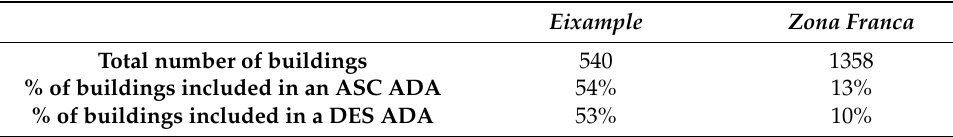
Table 6. Summary of the number of buildings in the case study areas.